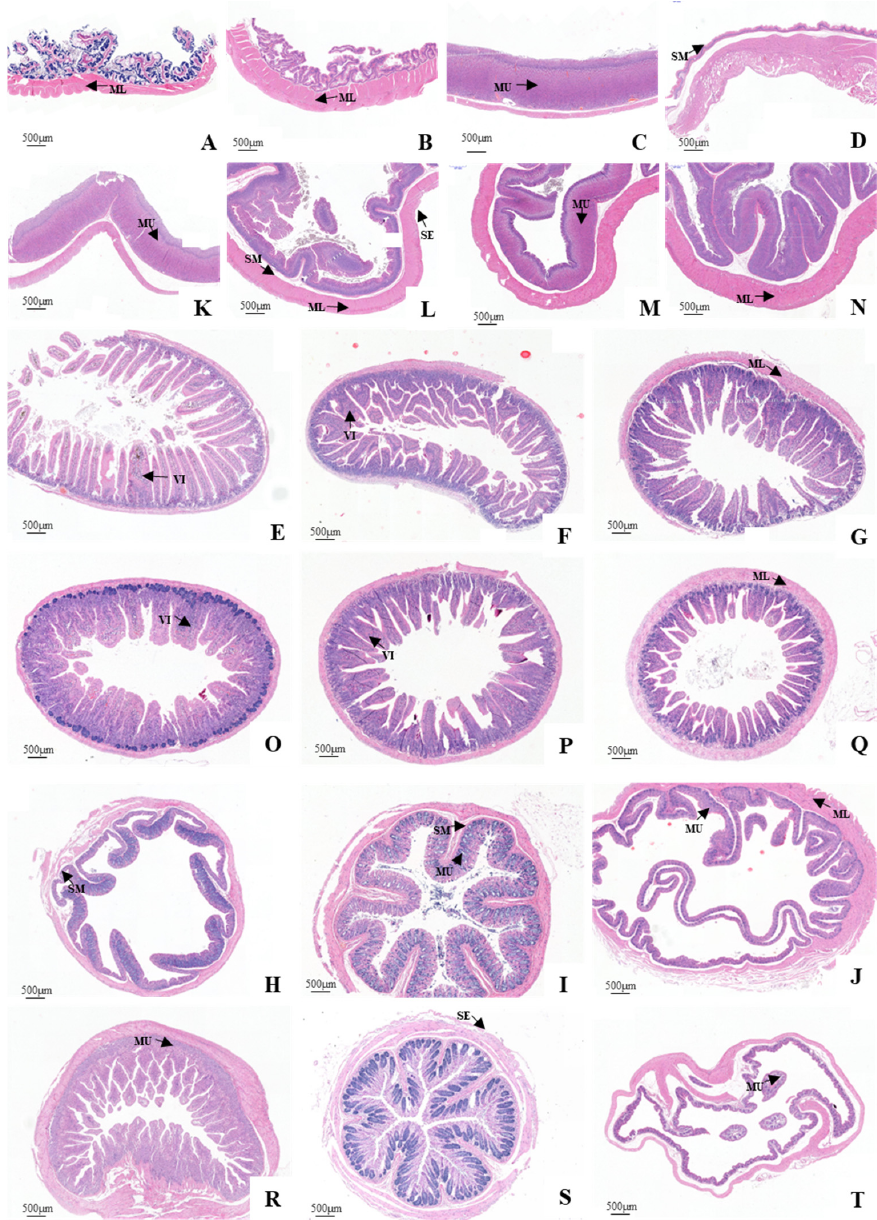
Figure 6. Comparison of the panoramic images of the tissue sections of the GIT of the plateau zokor and plateau pika (40 × magnification). ( A – J ) Stomach, (( A – D ) fundus, corpus I, corpus II, and pylorus of stomach), duodenum, jejunum, ileum, colon, rectum, and cecum of the plateau zokor, respectively; ( K – T ) gastrointestinal organs of the plateau pika in the same order as above. ML: muscularis; MU: mucosa; SE: serosa; SM: submucosa; VI: villi.